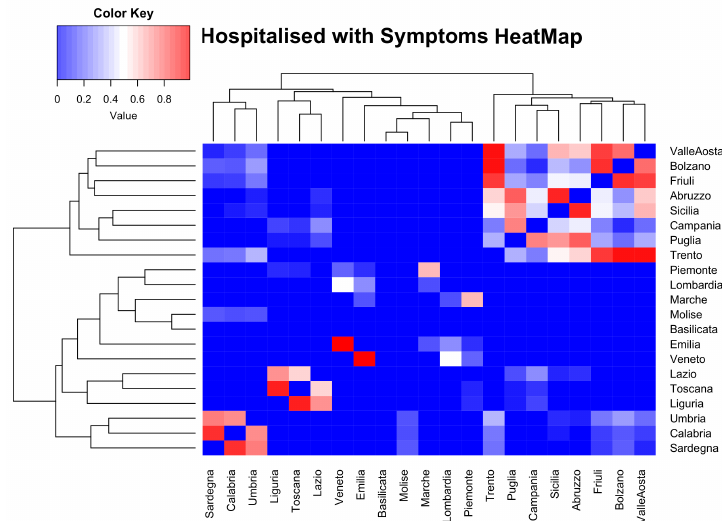
Figure 2. The figure shows the heat map related to results obtained by applying Wilcoxon Sum Rank test in the study period on Hospitalized with Symptoms